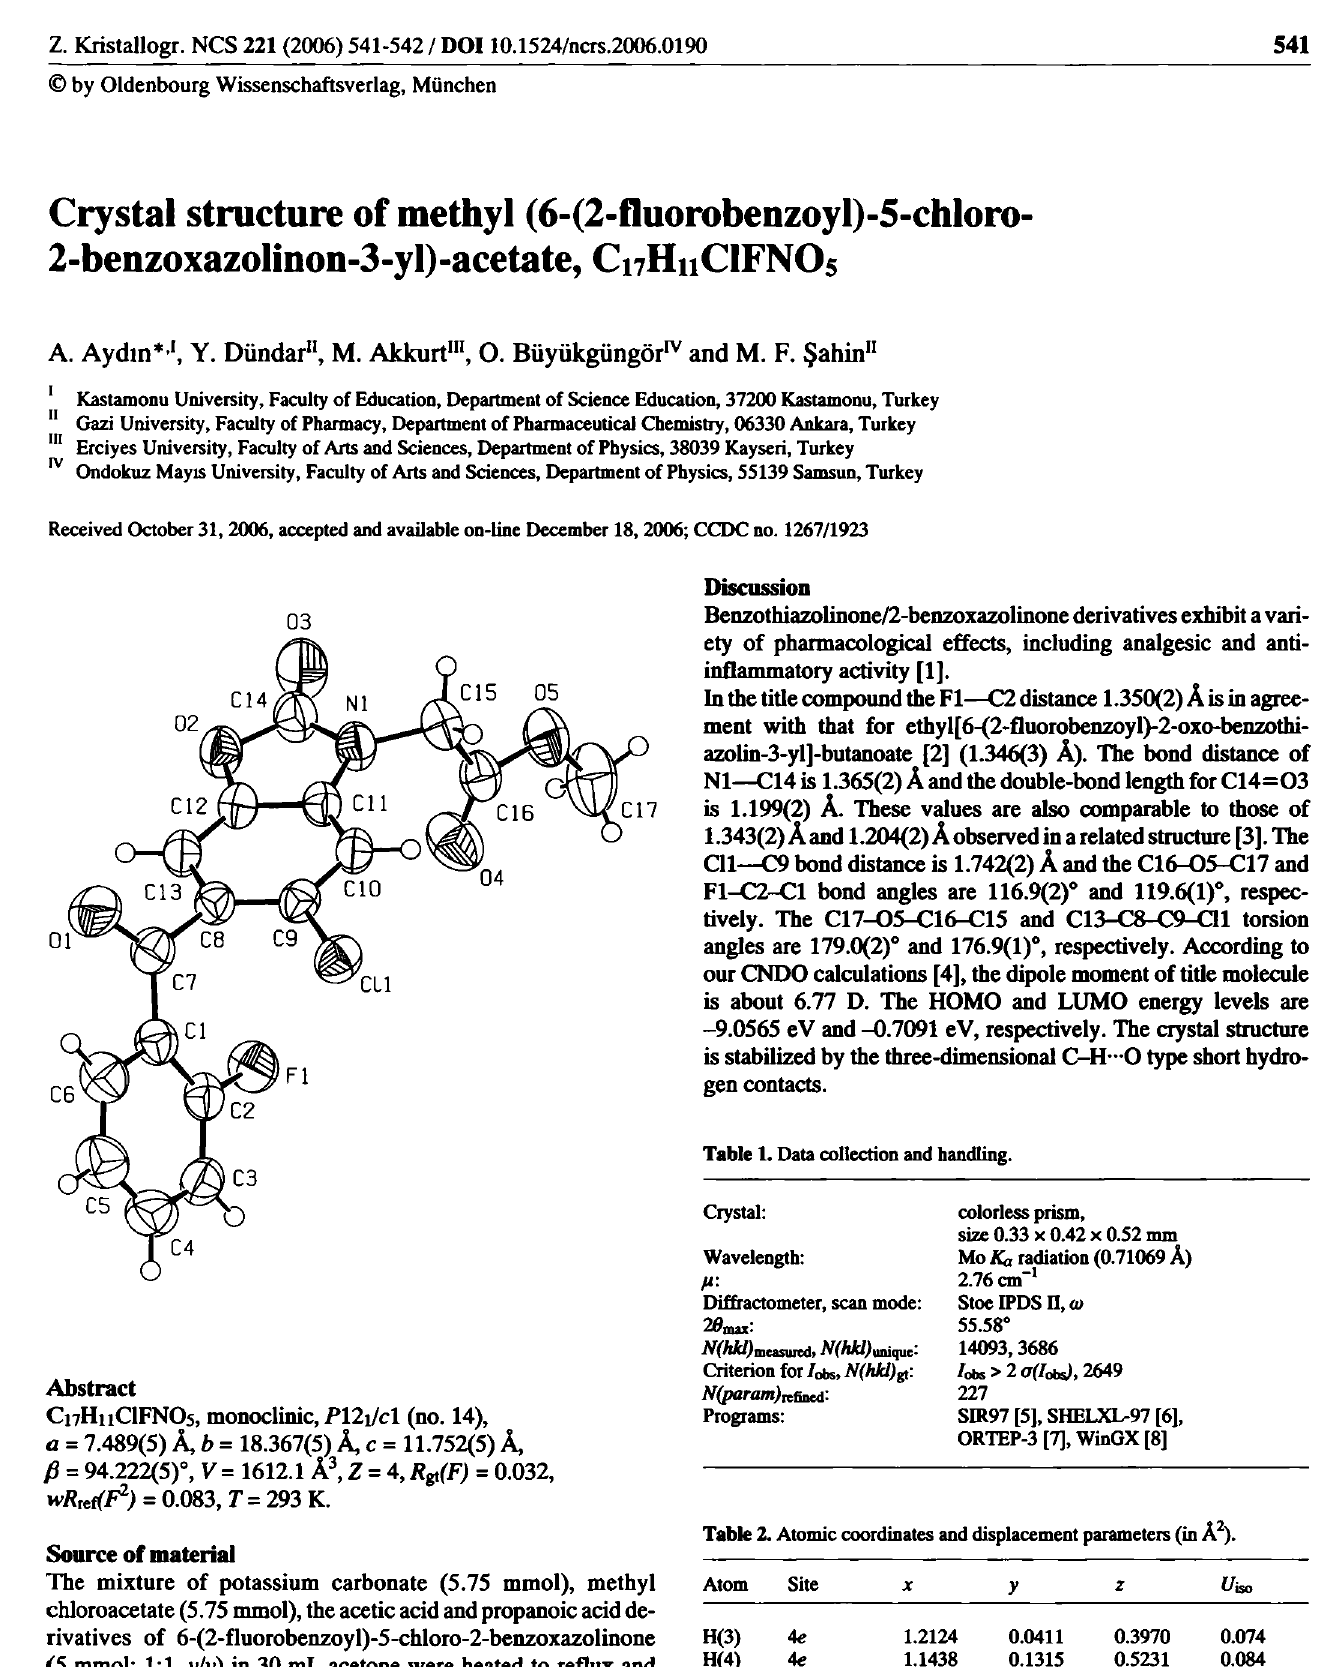
Table 2. Atomic coordinates and displacement parameters (in A 2